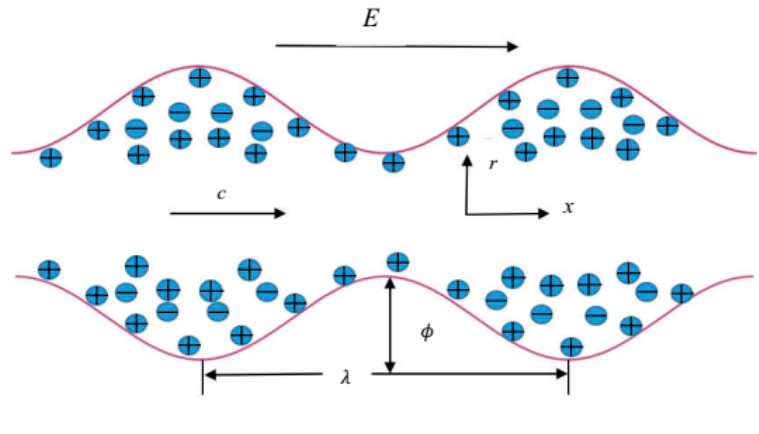
Figure 1. Geometry of the problem.